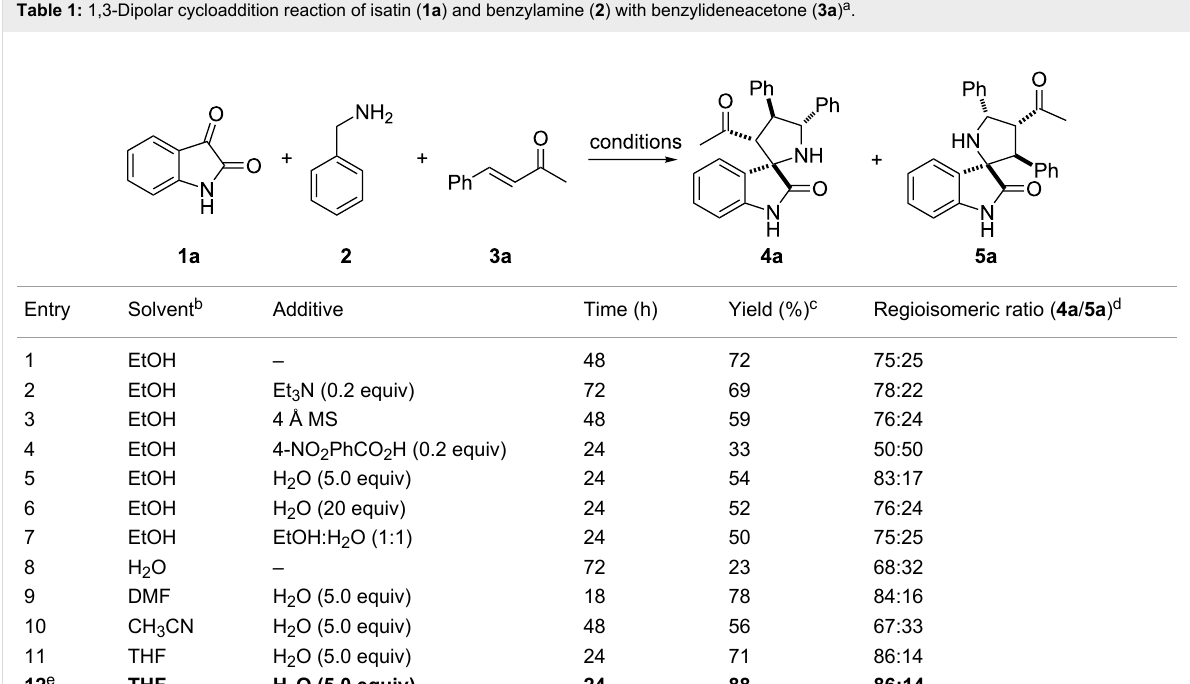
Table 1: 1,3-Dipolar cycloaddition reaction of isatin ( 1a ) and benzylamine ( 2 ) with benzylideneacetone ( 3a ) a